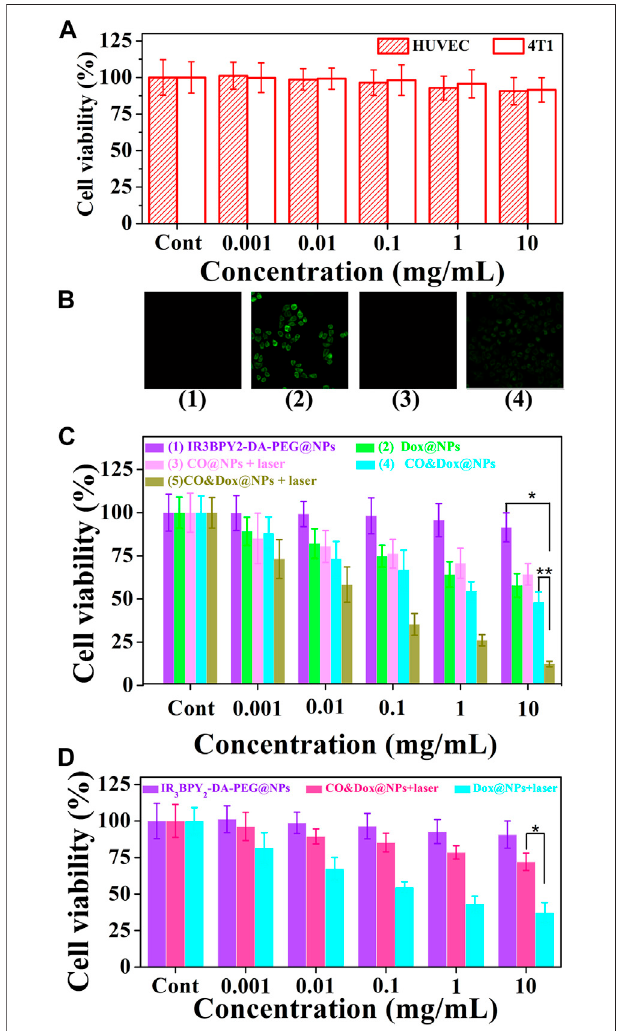
FIGURE6| Cellexperiment. (A) Cytotoxicitypro fi lesofbothHUVECand 4T1 cells. (B) Intracellular controlled release of CO from IR 3 BPY 2 -DA-PEG@ NPs with irradiation (1), CO&Dox@NPs with irradiation (2), CO&Dox@NPs without irradiation (3), and COPIRS with irradiation (4). (C) Cell viability of 4T1 after co-culturing with different samples and treatment: (1) IR 3 BPY 2 -DA- PEG@NPs,(2)Dox@NPs,(3)CO@NPs,(4)CO&Dox@NPs,and(5)CO&Dox@ NPs. Groups 3 and 5 were subjected to NIR irradiation for 10 min. (D) Cell viability of HUVEC after co-culturing with IR 3 BPY 2 -DA-PEG@NPs, CO&Dox@ NPs with irradiation, Dox@NPs with irradiation. The concentration is all in terms of IR 3 BPY 2 -DA-PEG@NPs, and “ Cont ” means the concentration is 0. * p < 0.001, ** p <